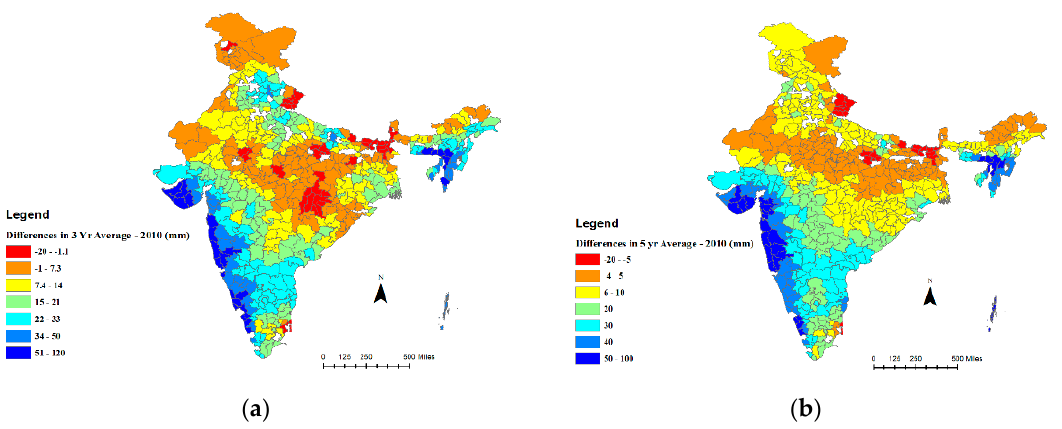
Figure 4. Spatial variation based on differences between the three-year and five-year average rainfall deviation levels for 2000 to 2003 and 2007 to 2010. Left: The spatial variation in differences in three-year rainfall shocks for 2007 to 2010 and 2000 to 2003. Right: The spatial variation in differences in five-year average rainfall shocks for 2010 to 2005 and 2005 to